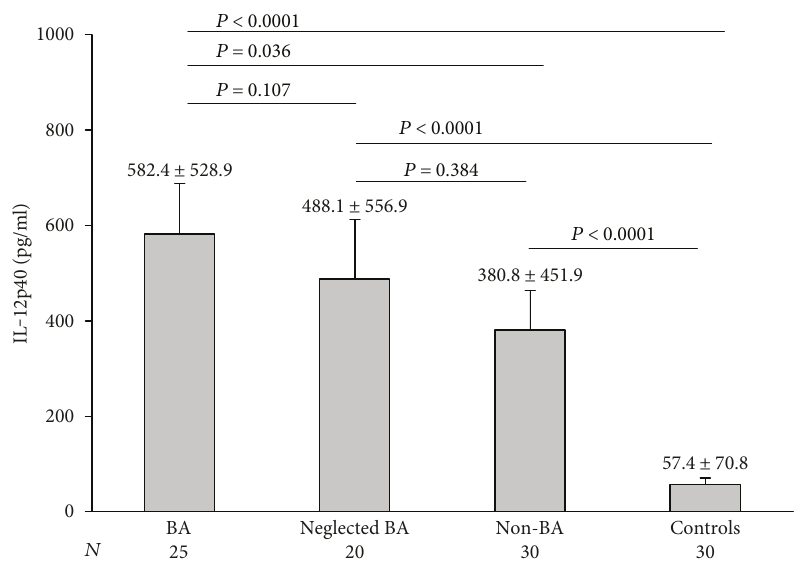
Figure 1: Preoperative serum IL-12p40 in the studied groups. The columns represent the mean, while the error bars represent the standard deviation. The horizontal bar represents the signi fi cance between the designated